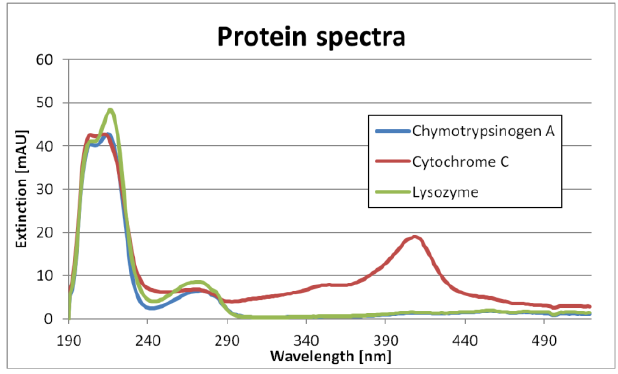
Figure 1. Single-component spectra of Chymotrypsinogene A, Cytochrome C and Lysozyme.